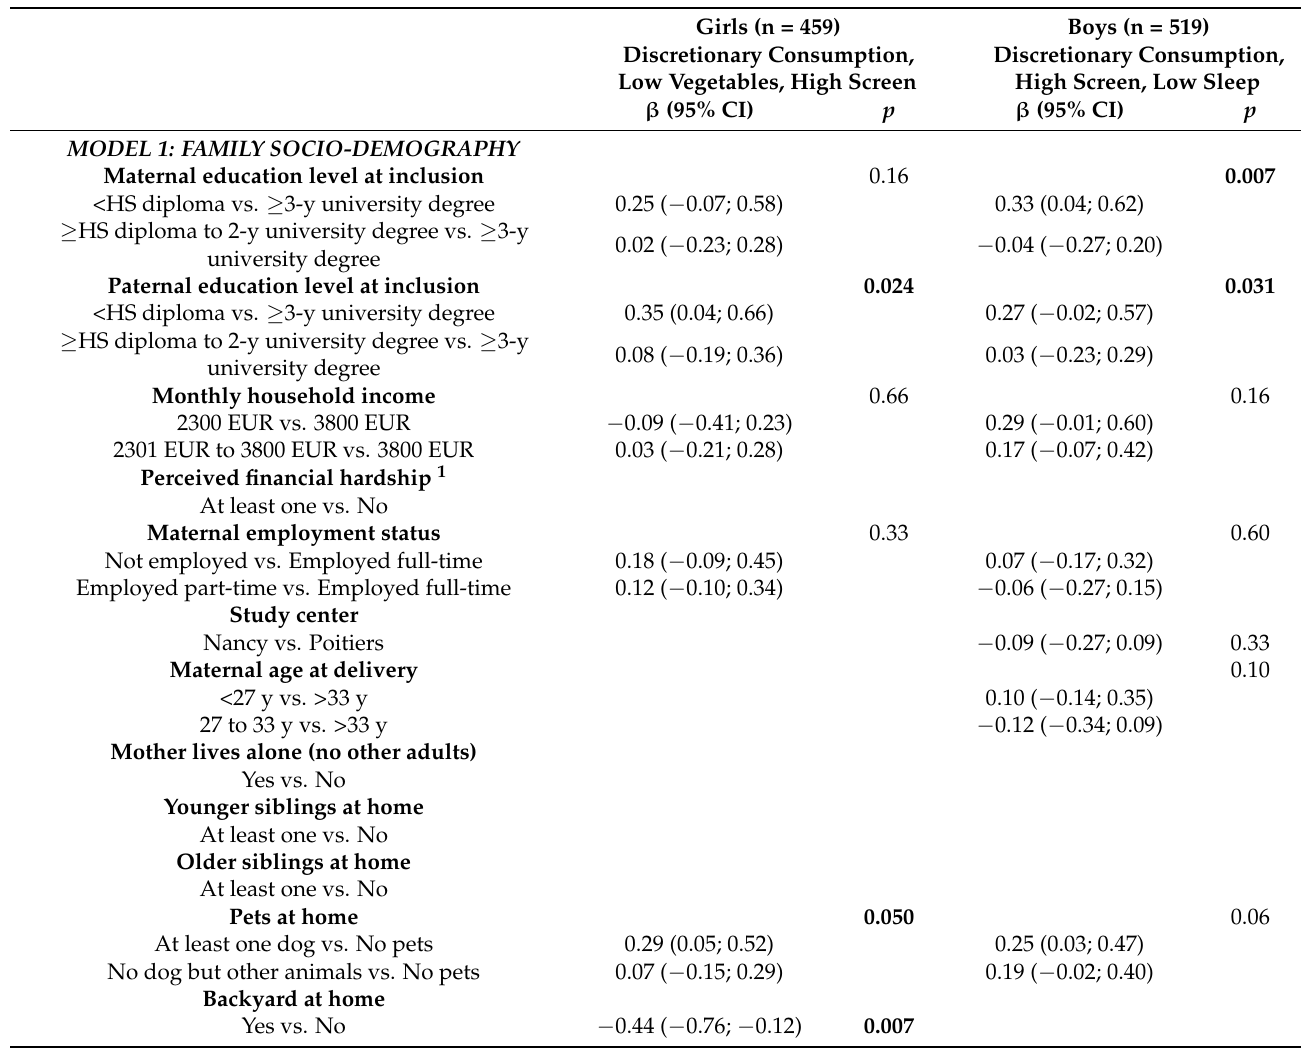
Table 3. Betas (95% CI) from multiply imputed and weighted hierarchical multivariable linear regression analyses stratified by sex, with unhealthy lifestyle patterns as the dependent variables. The EDEN